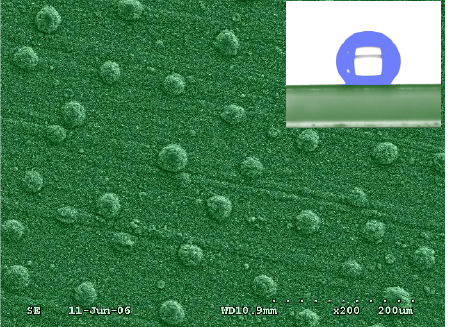
Figure 8. SEM of the ZnAl-LDH-laurate hybrid film showing the hemispherical protrusions. ZnAl-LDH-La/Al. The inset shows the image of contact angle of a water droplet on the surface of the ZnAl-LDH-laurate hybrid film.